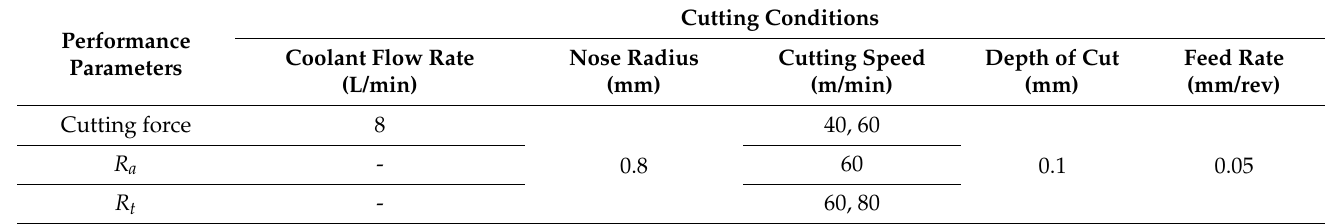
Table 8. Optimal cutting